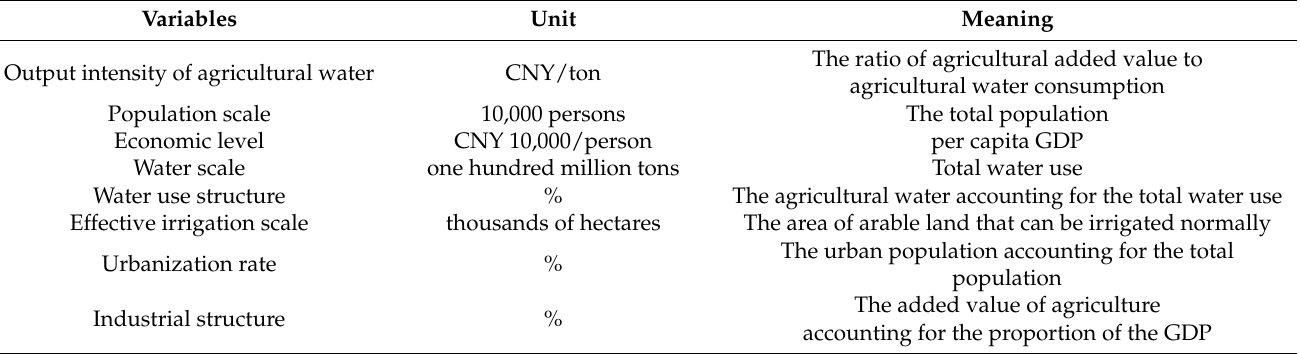
Table 1. Description of relevant